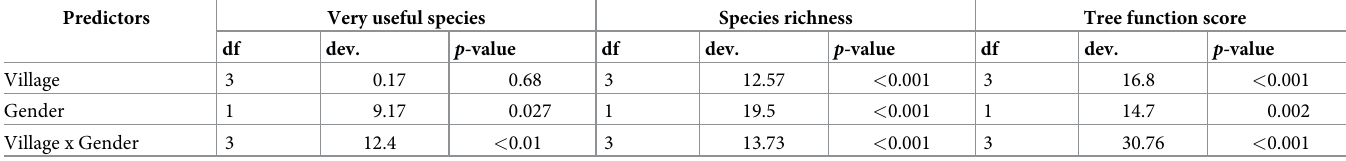
Table 5. Results of the generalized linear models showing the relationship between gender and village, with useful tree species, species richness and tree function score in Ziro province of Burkina Faso. Predictors